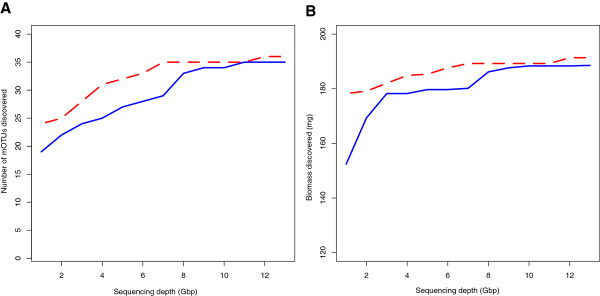
Rarefaction curves for discoveries of (A) MOTUs and (B) biomass. With increasing sequence quantity, discovery rates for MOTUs and biomass are both improved, using a reference-based method (red dashed line) and a reference independent method (blue solid line).